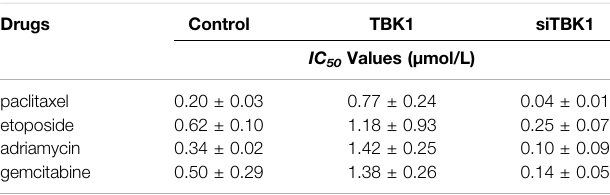
TABLE 7 | The effect of TBK1 overexpression or knockdown in HepG2 cells to Cytotoxic chemotherapies. Drugs Control TBK1 siTBK1